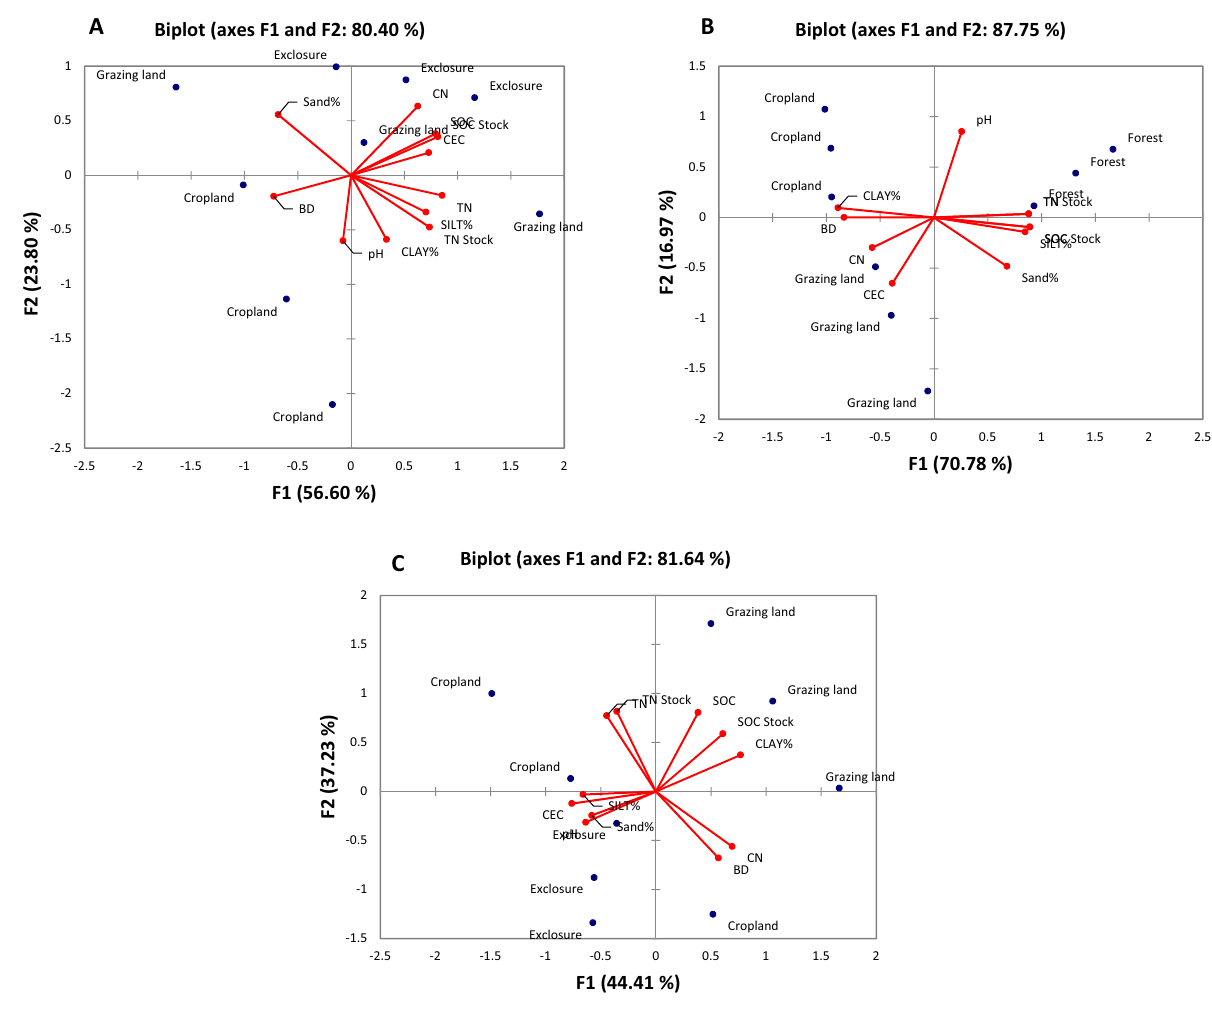
Figure 4. Biplots of ( A ) Geregera ( B ) Desa’a, and ( C ) Haikihelet locations as influenced by land use. Soil physico-chemical characteristics: BD = bulk density, Soil texture (sand%, silt% and clay%), SOC = soil organic carbon, TN = total nitrogen, CEC = cation exchange capacity, CN = C:N ratio. The red arrow denotes the direction of the high weighting of soil physico-chemical characteristics in the first (FA-1) and second factor